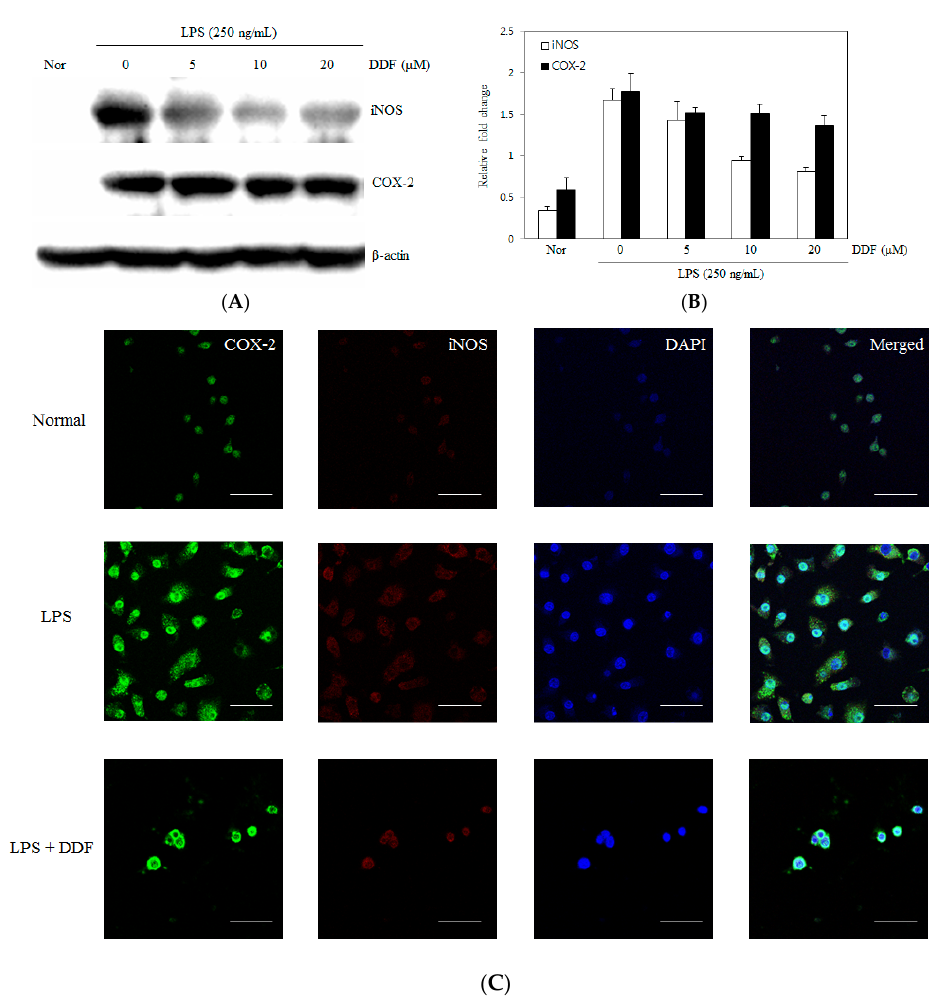
Figure 4. Inhibition of inducible nitric oxide synthase (iNOS) protein expression by DDF. ( A ) RAW 264.7 cells were pretreated with different concentrations of DDF for 30 min and stimulated with LPS (250 ng/mL) for a further 24 h. Equal amounts of proteins in the cell lysates were separated by electrophoresis, and the protein expression levels of iNOS and COX-2 were determined with specific antibodies against iNOS and COX-2; ( B ) Immunoblot signals were quantified using Molecular Analyst/PC densitometry software (Version 4.6, Bio-Rad, Hercules, CA, USA), and densitometric analysis is reported. The contents of iNOS and COX-2 in the cell lysate were normalized to the content of β -actin; ( C ) Expression of iNOS and COX-2 with DDF. Cells were cultured for 24 h with LPS (250 ng/mL), fixed, permeabilized, and incubated with rabbit polyclonal anti-iNOS antibody, followed by Alexa-488-conjugated anti-rabbit Ig (green), and with mouse polyclonal anti-COX-2 antibody followed by Alexa-594-conjugated anti-mouse Ig (red). The nuclei of the corresponding cells were visualized by DAPI staining (blue). Normal, untreated control cells; LPS, treatment with only LPS (250 ng/mL); DDF, 6.8-diprenyl-4 (cid:48) ,7-dihydroxyflavanone; (magnification: 60 , scale bars: 50 µ ×